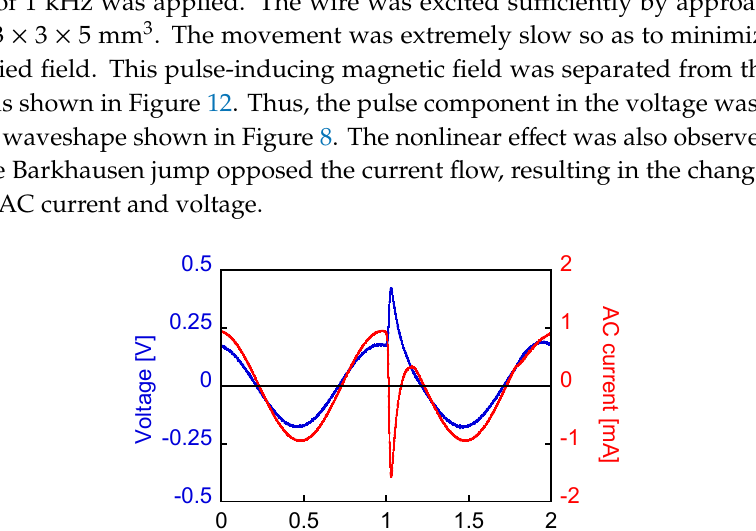
Figure 12. Application of an AC current of small amplitude where a large Barkhausen jump occurs due to the independent magnetic field of the slow-moving magnet shown in the circuit of Figure 3. 4. Conclusions In this work, equivalent circuit parameters of resistance and inductance of the wire-core coil used in Wiegand sensor were measured using an LCR meter and current-voltage characteristics under the excitation of alternating current. The inductance of the coil strictly reflected the magnetization state of the wire. At the moment when a large Barkhausen jump occurred, the coil underwent self-induction due to the fast propagation of the magnetic flux inside the wire. Consequently, the calculated inductance became negative. In order to optimize the performance of inductive coupling using the Wiegand sensor, the determination of internal parameters in the circuit design is required. The obtained experimental results of the nonlinear characteristics of the current and voltage and the time-dependent inductance of the Wiegand sensor are significant in developing applications of the Wiegand sensor. Author Contributions: Conceptualization, Y.T.; Methodology, T.Y.; Investigation, K.T.; Writing-Original Draft Preparation, K.T.; Writing-Review & Editing, Y.T. Funding: This research was funded by the JSPS KAKENHI grant number 17K18874. Conflicts of Interest: Conflicts of Interest: The authors declare no conflict of interest. References 1. Saritas: E.U.; Goodwill, P.W.; Croft, L.R.; Konkle, J.J.; Lu, K.; Zheng, B.; Conolly, S.M. Magnetic particle imaging (MPI) for NMR and MRI researchers. J. Magn. Reson. 2013 , 229 , 116–126. 2.